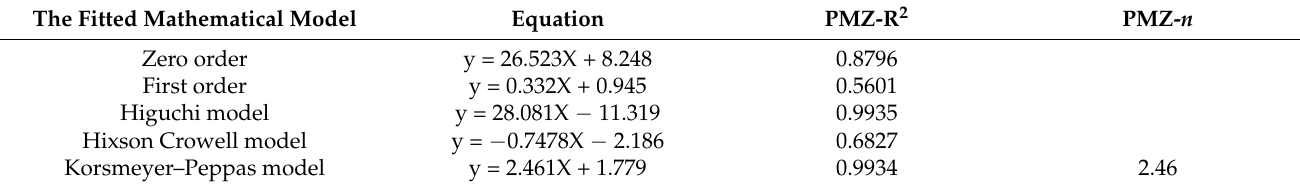
Table 7. The equation coefficients of determination (R 2 ) and the “ n ” value for each mathematical model for